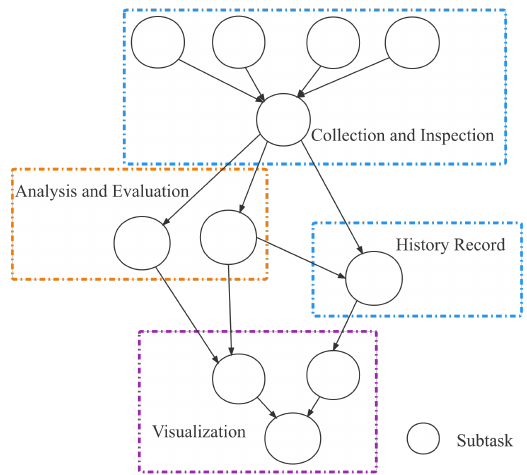
Figure 3. USVs intelligent water quality